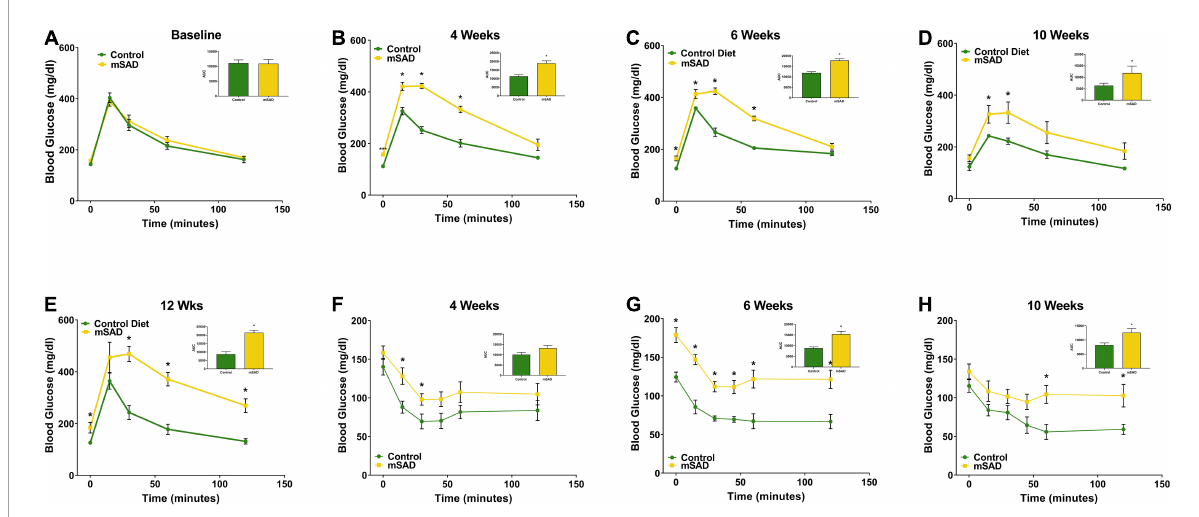
FIGURE3 Effects of diet on glucose and insulin response. Glucose tolerance tests were performed prior to the feeding regimen (A) and after weeks 4 (B) , 6 (C) , 10 (D) , and 12 (E) weeks of diet. Insulin tolerance tests were performed after weeks 4, (F) , 6 (G) , and 10 (H) weeks of diet. Values are represented as mean ± SEM ( n = 4–6/time point). Data were compared using Welch’s t -test. * p < 0.05.